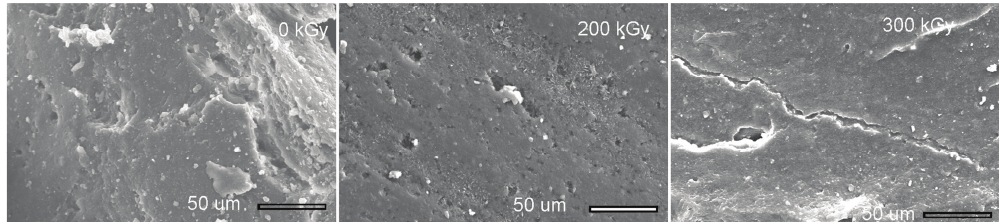
Figure 4: SEM image of waste tire particles at different irradiation dose.